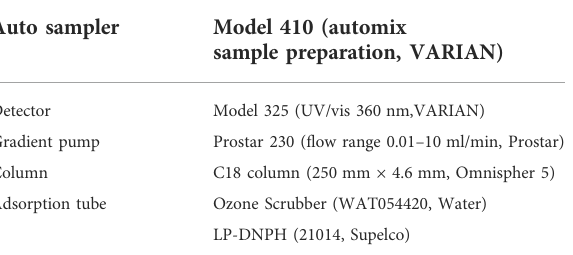
TABLE 3 The speci fi cation of high-performance liquid chromatography (HPLC).